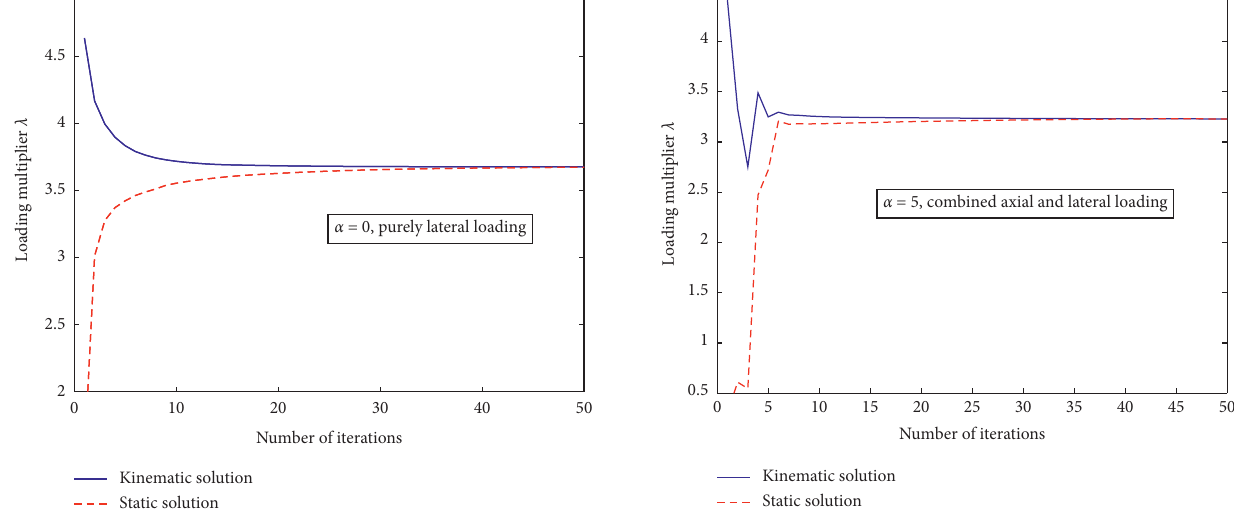
Figure 8: Variations of the kinematic and the static loading multipliers for α � 5.